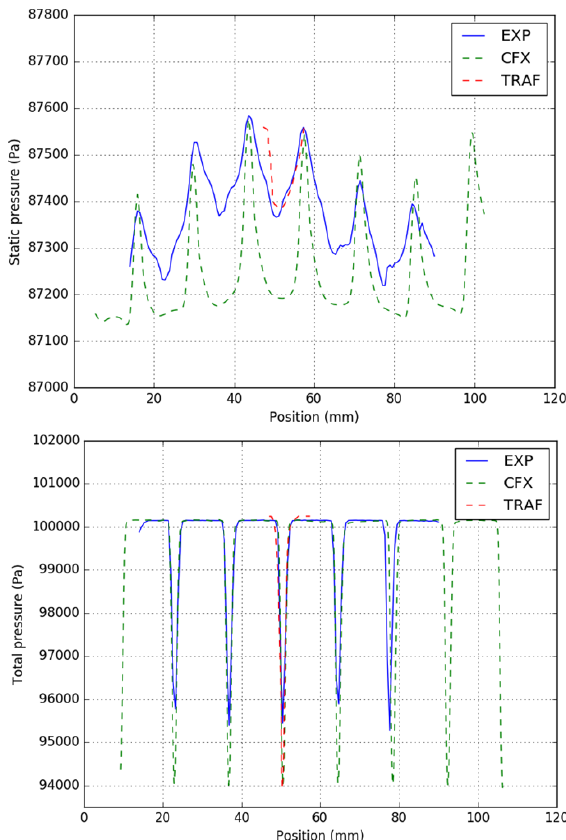
Figure 9. Comparison of the experimental and CFD data of CFX and TRAF (static pressure (up) and total pressure (down) in the traverse plane downstream of the blade cascade shown in Fig. 2).